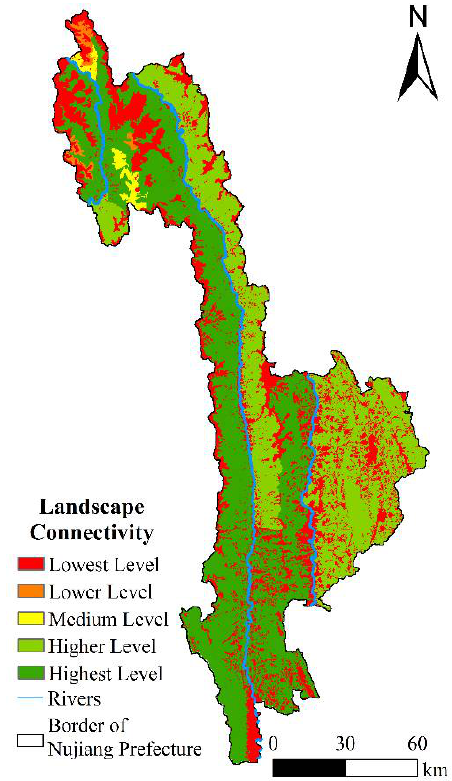
Figure 6. Landscape connectivity in Nujiang Prefecture.